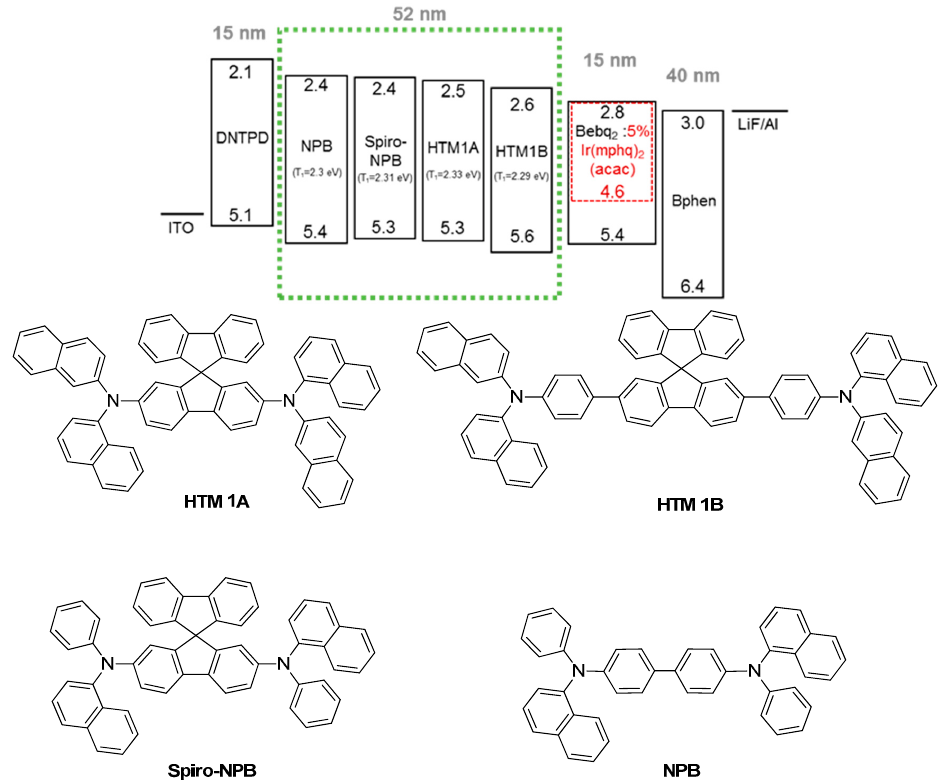
Figure 4. Configuration of red phosphorescent based OLED device and structure of hole transporting materials used for device fabrication.